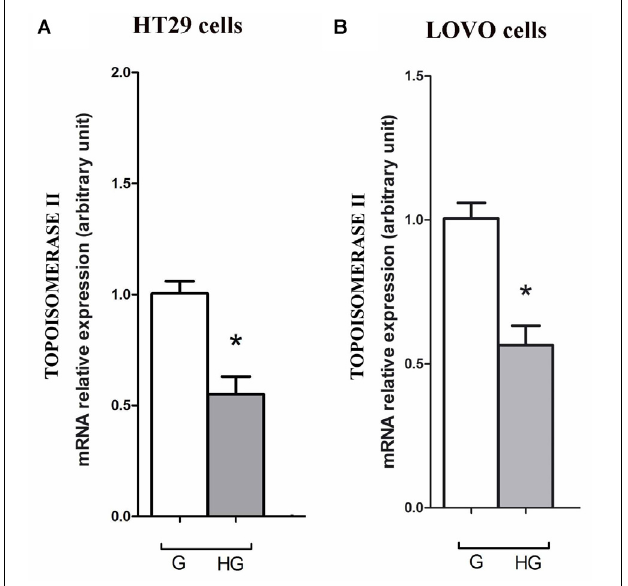
FIGURE 13 | Effect of normal glucose (G) and high glucose (HG) on mRNA expression and in absence or presence of DOX in human colon cancer (HT29 (A) and LOVO (B) ) cells. Cells were cultured for ≥ 7 days in the presence of G and HG, then washed and processed to determine the Topoisomerase II mRNA expression. The figure is representative of three independent experiments. Cells were analyzed by quantitative real-time polymerase chain reaction (RT-qPCR). Measurements ( n = 6) were performed in triplicate, and data are expressed as relative expression; (A) ∗ p < 0.01 HT29 cells cultured in HG vs. HT29 cells cultured in G and (B) ∗ p < 0.01 LOVO cells cultured in HG vs. LOVO cells cultured in G.